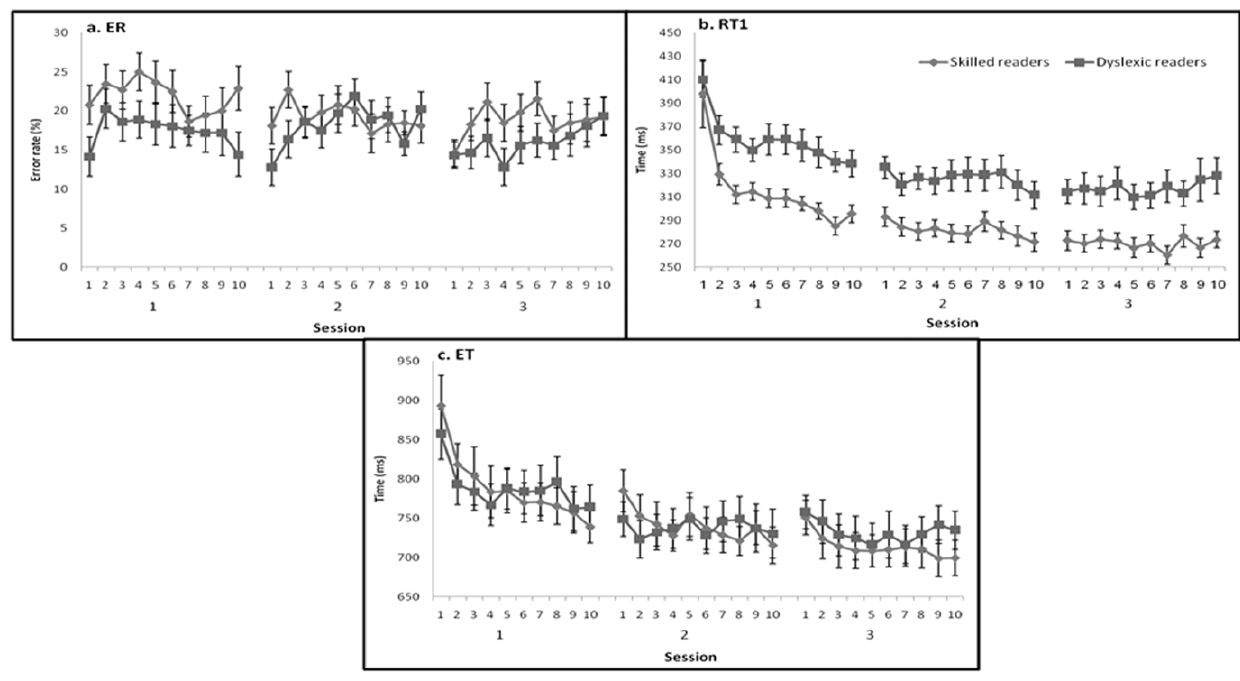
Figure 4. The group mean value of the volitional manual task parameters for dyslexic and skilled readers throughout the training program. a. ER. b. RT1, and c. ET. Error bars indicate group standard error.